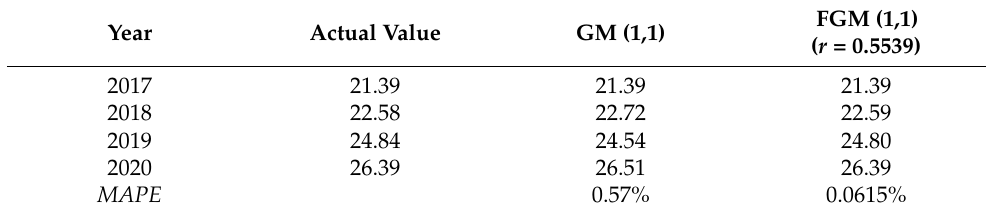
Table 1. The MAPE of GM (1,1) model and FGM (1,1) model (Trillion yuan).